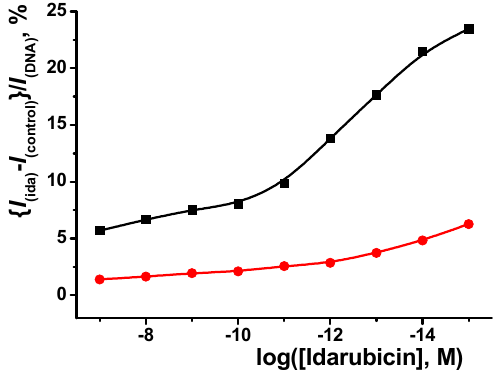
Figure 10. Comparison of idarubicin calibration curves in standard solutions (black) and in com- mercial medication Zavedos ® (red) on PAB-2/DNA-MB, cyclic voltammetry, 0.1 M HEPES buffer containing 0.03 M NaCl, pH 7.0.